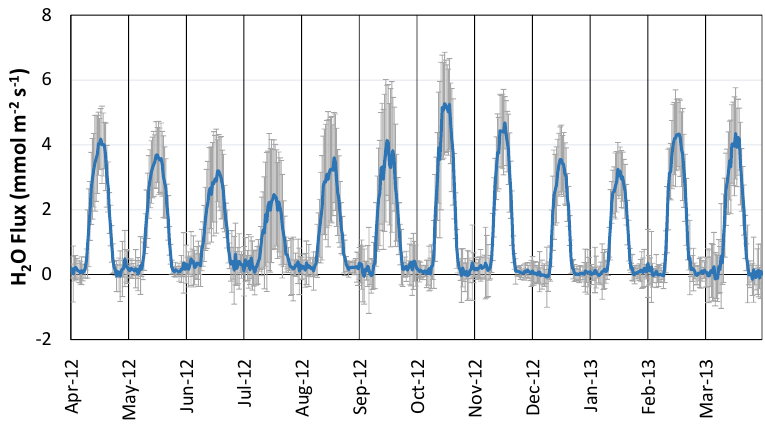
Figure 8. Monthly mean diurnal variations of half ‐ hourly H 2 O flux during April 2012 to March 2013. The error bars show one standard deviation of the diurnal average fluxes during the respective months.